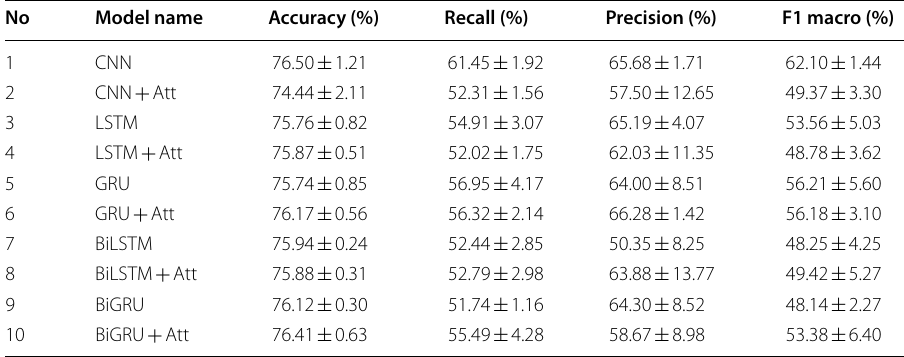
Table 4 Result of argument annotation using deep learning model with attention mechanism (FastText Word